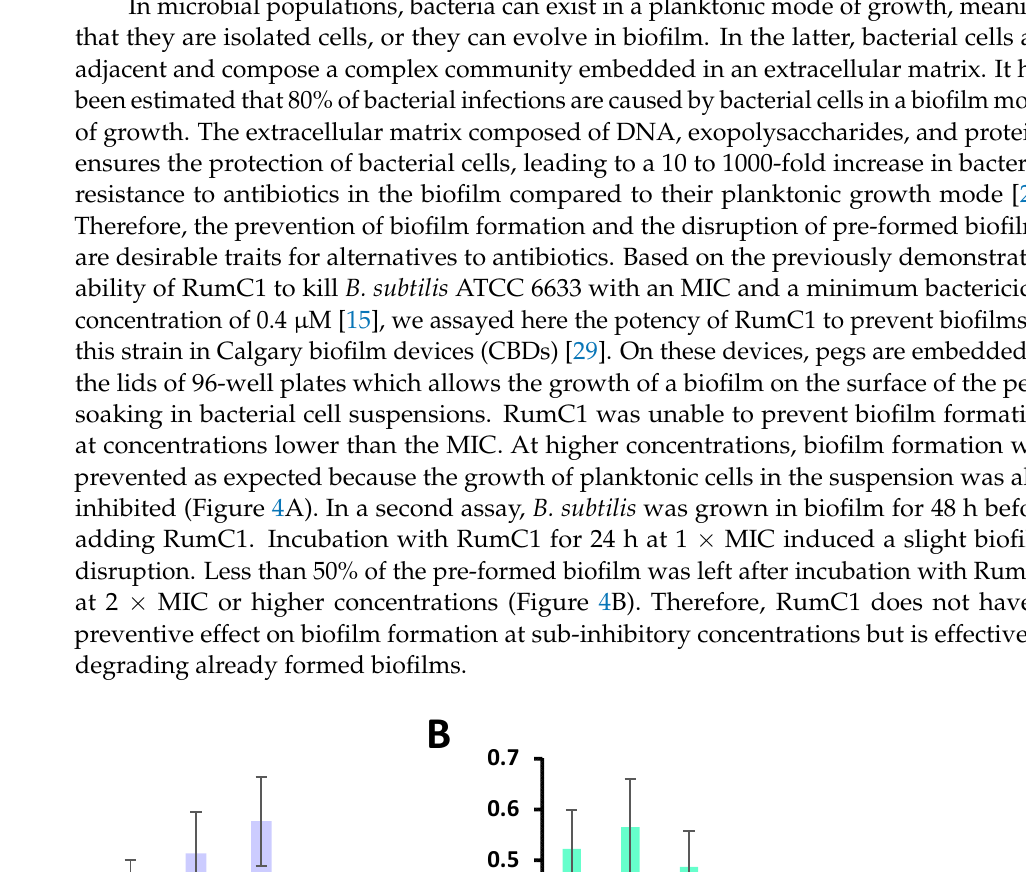
shown on the figure as well as their correlation with metabolite production using a color gradient from red (poor producer) to green (good producer), respectively. ( B ) SCFA production and fermentation parameters for each group were statistically analyzed by ANOVA test. SEM = standard error of the mean. Slope, maximum pressure, and pH were the parameters measured during the fermentation. Slope = rate of gas production in the exponential phase, max pressure = maximum gas production in 24 h, pH = final pH after 24 h of fermentation.